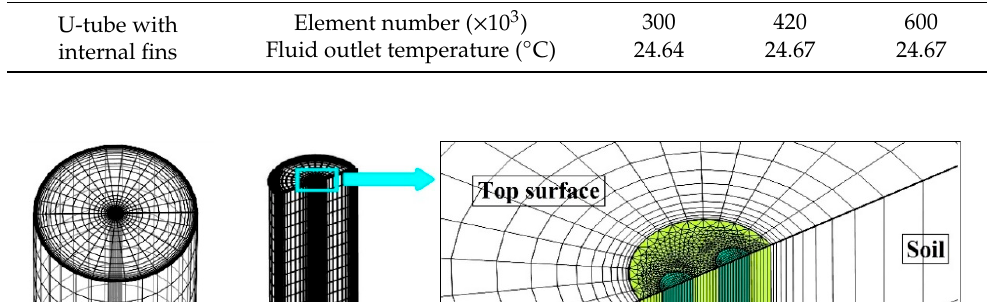
Table 4. Physical properties of